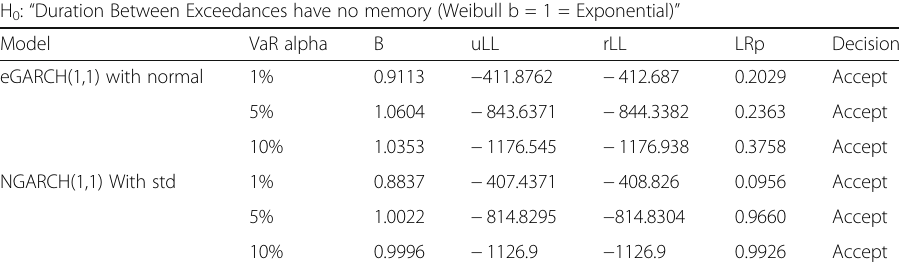
Table 9 Implements the VaR Duration Test of Christoffersen and Pelletier on Total Nigeria Plc Returns H 0 : “ Duration Between Exceedances have no memory (Weibull b = 1 = Exponential) ” Model VaR alpha B uLL rLL LRp Decision eGARCH(1,1) with